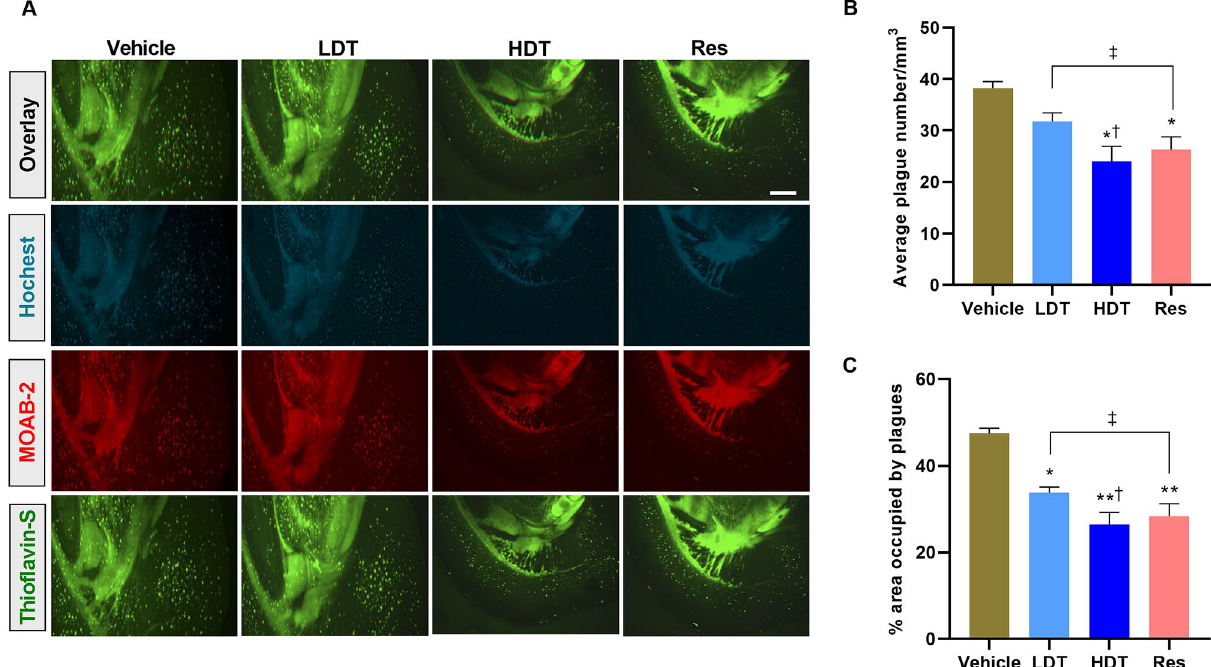
Figure 4. Confocal microscope immunoreactive studies to examine Aβ plaque deposition in the cortex region of 4-month-old 5xFAD mice brain after 45 consecutive days (P30-75) treatment with W. somnifera . ( A ) Representative images at × 100 of combined immunofluorescence and Thioflavin-S staining of the mice brain coronal sections, scale bar = 500 μm. ( B ) Quantification of the average number of Aβ plaque deposition. ( C ) Percentage of the area occupied by the plaques. The data represent the mean ± SEM. Data were from 4 different mice in each group (n = 4 of two independent sessions) using one-way ANOVA followed by Tukey’s multiple comparisons test. Significance is indicated by * p < 0.05; ** p < 0.01 versus vehicle; by † p < 0.05 between W. somnifera treated groups; by ‡ p < 0.05 between W. somnifera and Res treated groups. Vehicle control group, LDT low dose treatment, HDT high dose treatment, Res